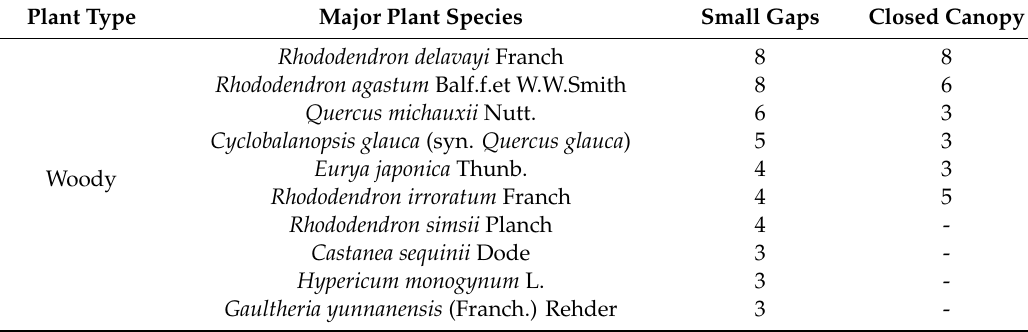
Table 1. Ranking of major plant species abundance in small gaps and closed